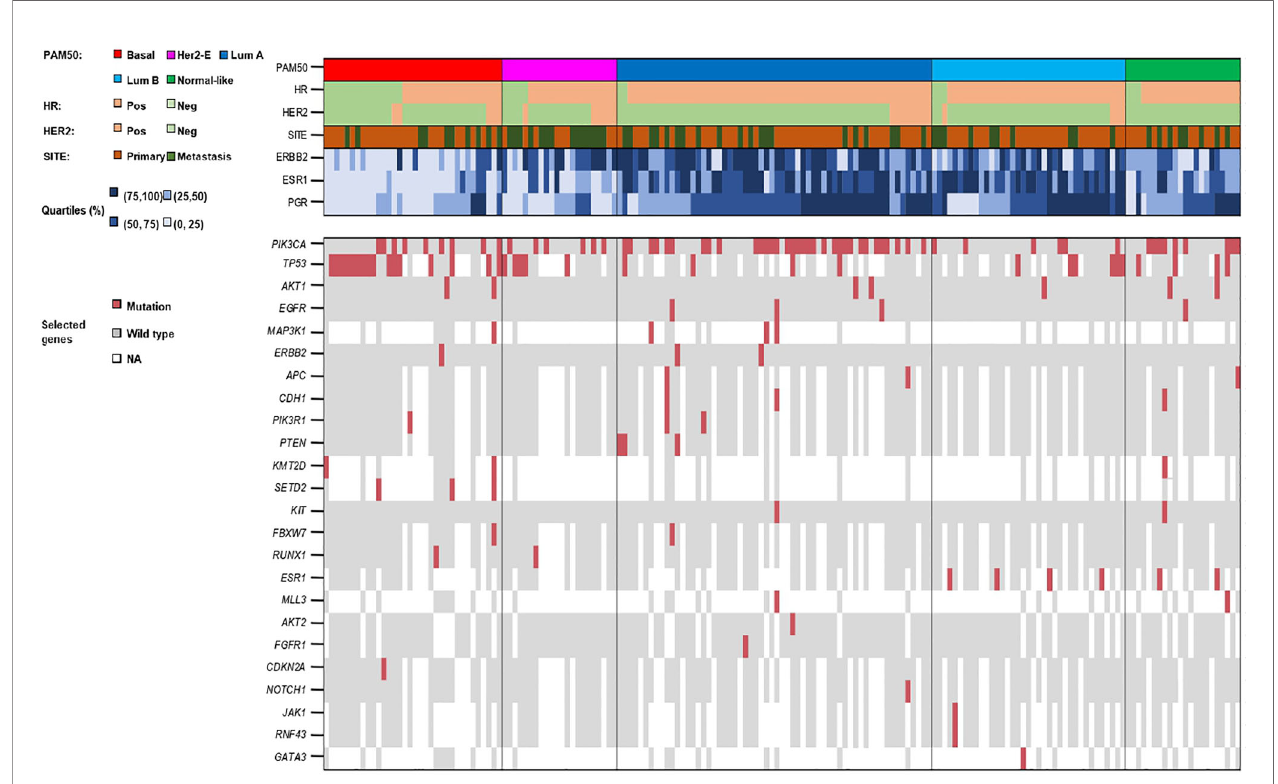
FIGURE 5 | Summary of biological and genomic features of the 177 gene expression pro fi led tumors.